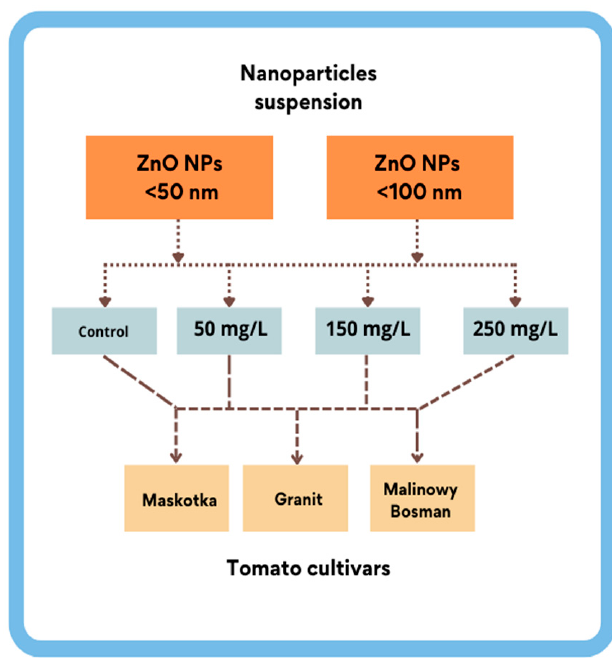
Figure 1. Illustration of research scheme.